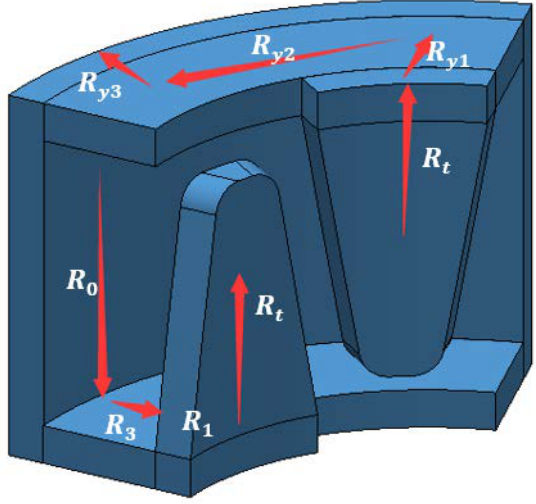
Figure 5. Schematic diagram of the magnetic flux path.